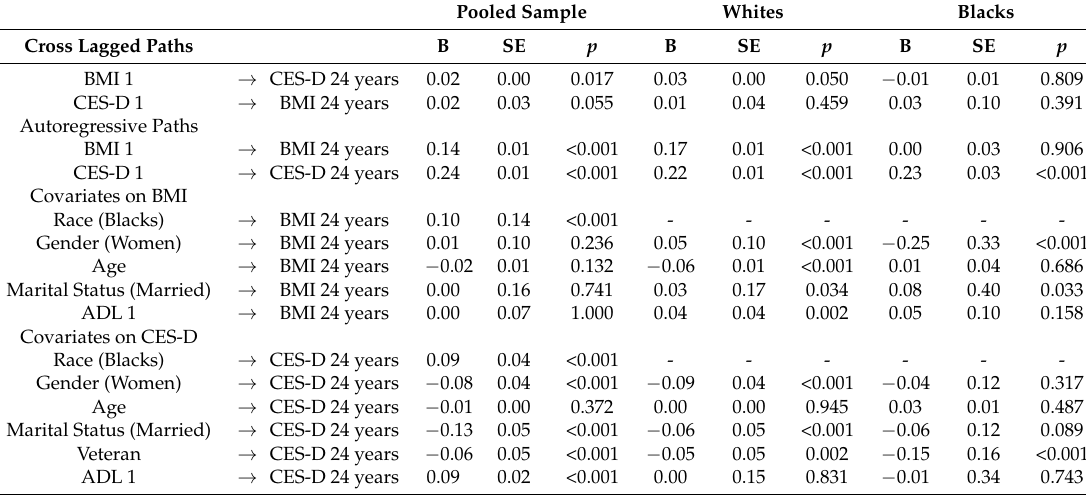
Table 3. Path coefficients (SEM) in the pooled sample and based on race. Pooled Sample Whites